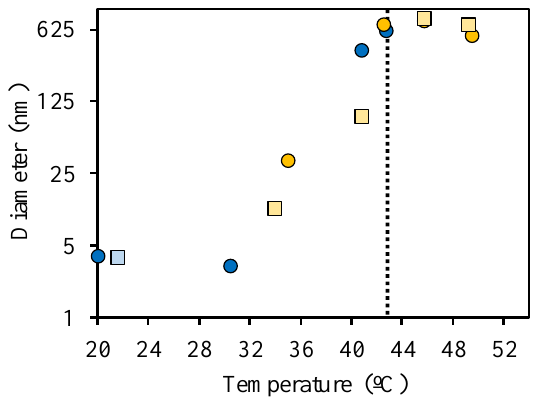
Figure 4. Variation of hydrodynamic diameter (measured by dynamic light scattering, DLS) with temperature for block copolymer chains in water for heating (blue circles) and cooling (blue square) cycles, and for the mixture of 1:1 SRP:DNA for heating (orange circles) and cooling (orange squares) cycles. The SRP concentrations were 2 × 10 − 5 M and 1 × 10 − 5 M for the SRP solution and 1:1 SRP:DNA mixture, respectively. The dotted line represents the T VPT (43 ◦